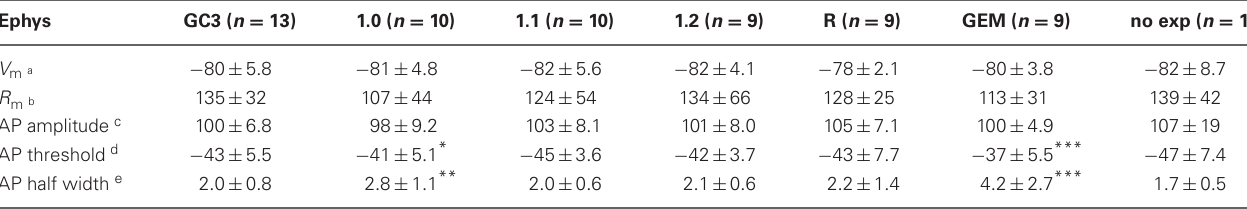
Table 2 | Electrophysiological properties of layer 2/3 pyramidal cells expressing GCaMP3 and GECOs.